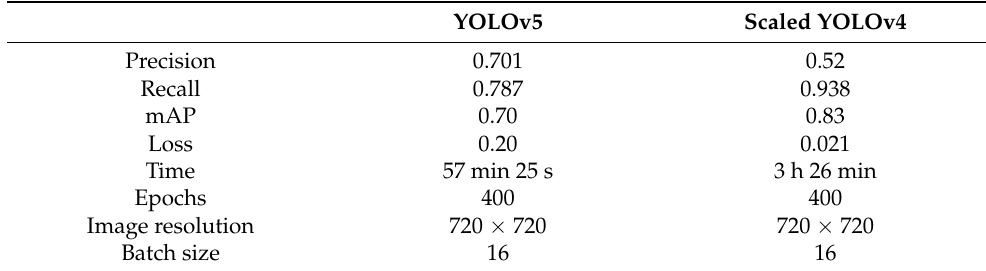
Table 5. Preliminary results for parasite